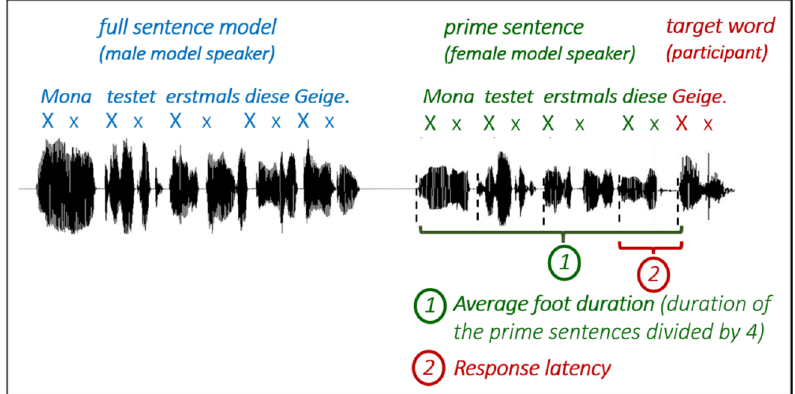
Figure 1. Overview of the procedure and data analysis.